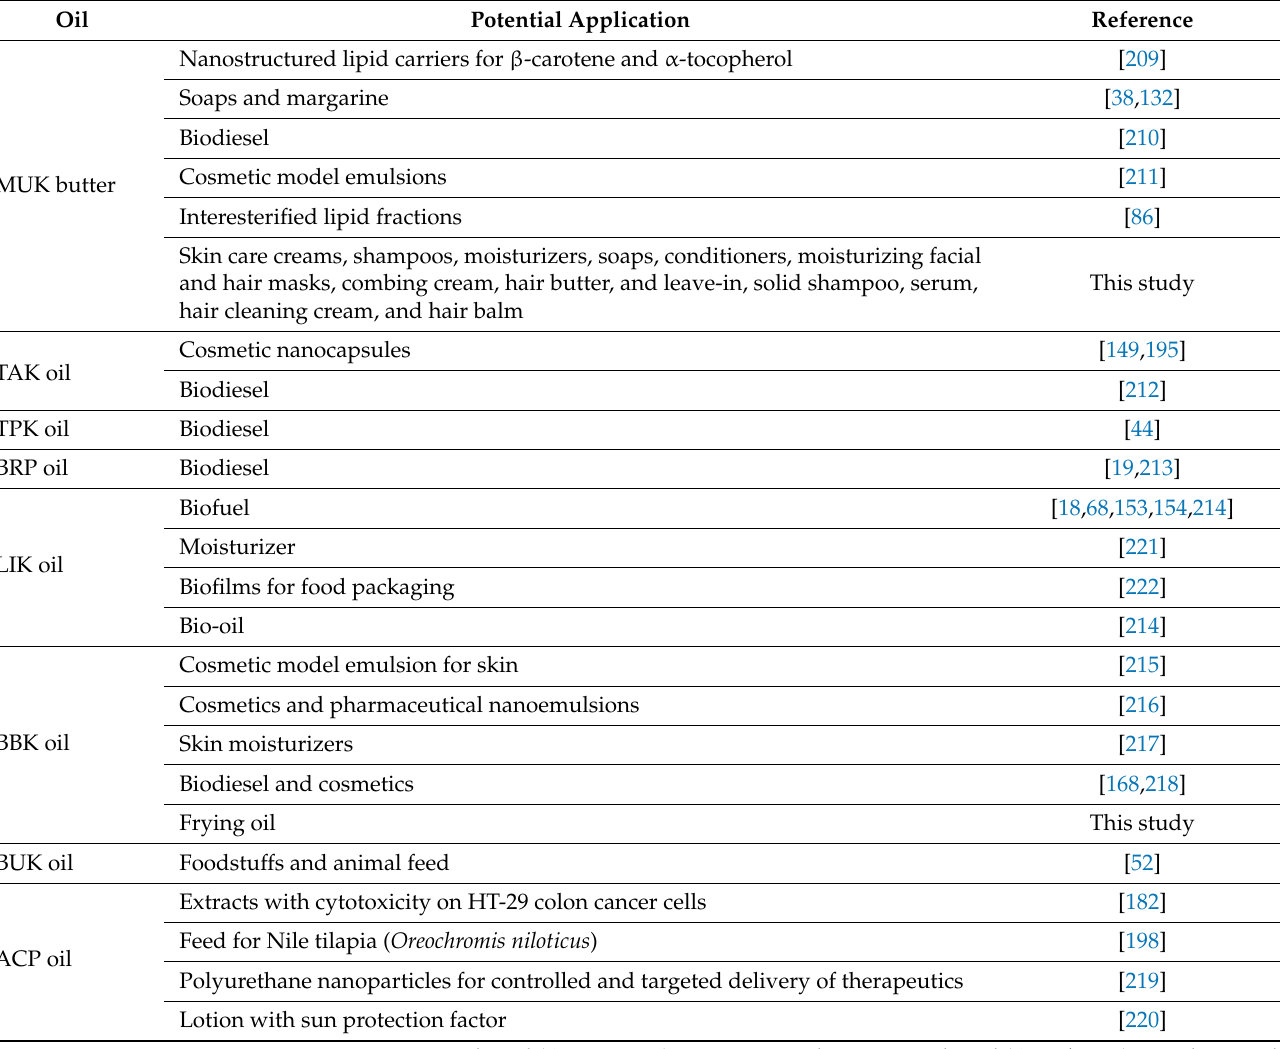
Table 6. Potential applications of Arecaceae palm tree fruit